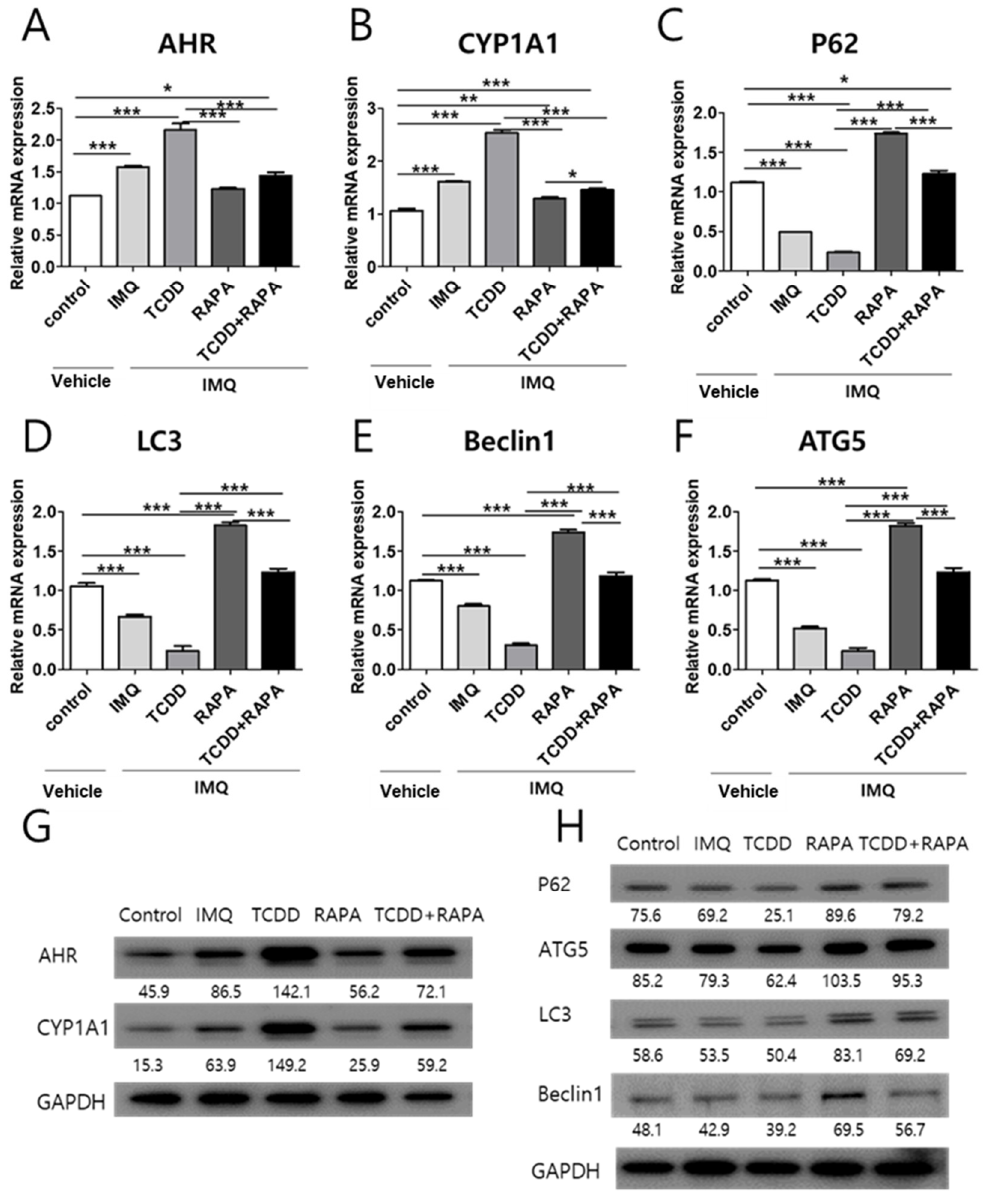
Figure 5. mRNA and Western blot analysis of AHR, CYP1A1, and autophagy-related factor expression changes in skin tissue with treatment with vehicle control, IMQ, IMQ + TCDD, and IMQ + Rapa, or IMQ + TCDD + Rapa. RNA and protein were extracted from the back skin. ( A – F ) qPCR and ( G , H ) Western blot analysis of AHR, CYP1A1, P62, ATG5, LC3, and Beclin1 expressions in mice treated with 5 different regimens ( n = 5 per treatment group). qPCR data represent the mean ± standard deviation (SD) of three independent experiments (each performed in duplicate). Statistical differences were determined by one-way analysis of variance (ANOVA) followed by post hoc Dunnett’s test. * p < 0.05; ** p < 0.01; *** p < 0.001. Western blot normalization was based on GAPDH. Western blot data are representative of three independent experiments. IMQ: imiquimod, Rapa: